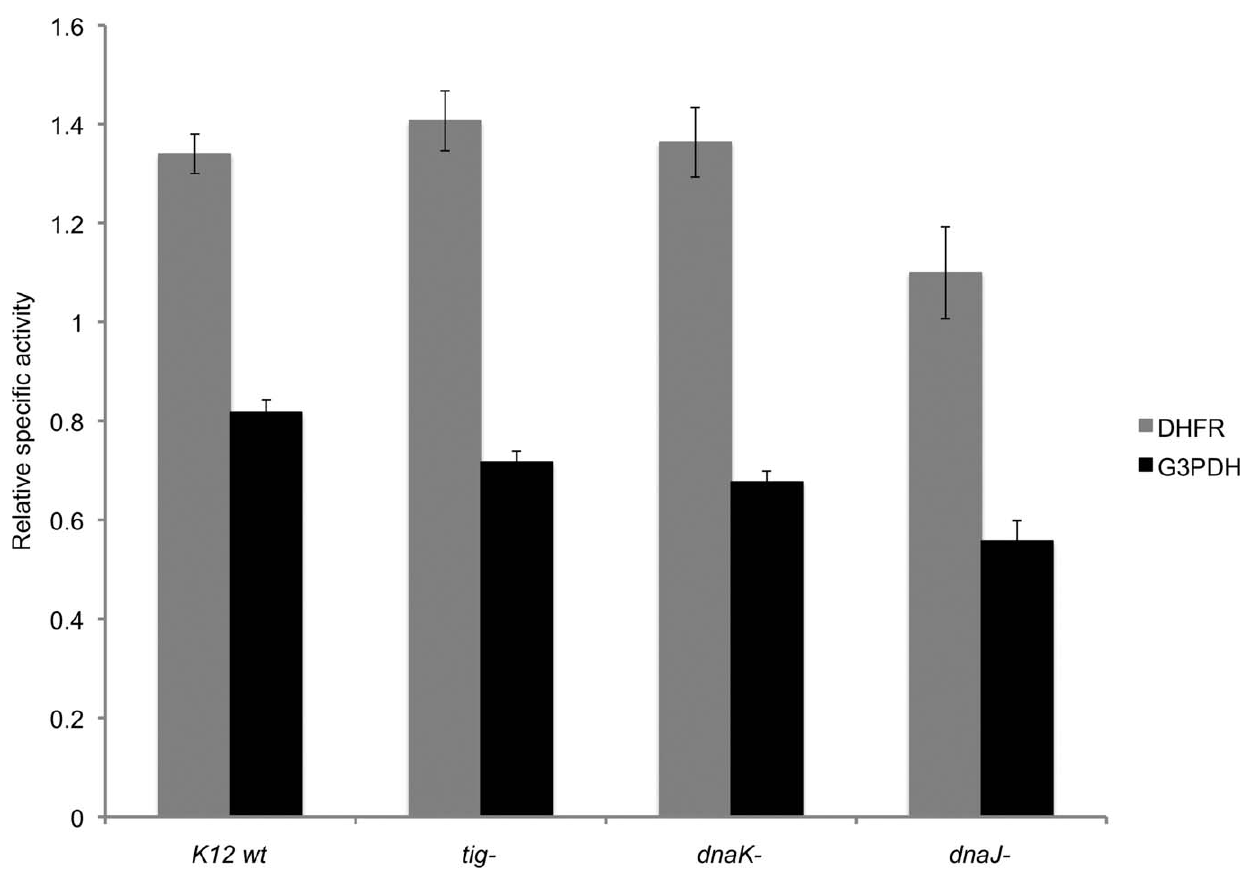
Figure 3. The effect of dnaJ , dnaK and tig gene deletions on the enzymatic activity of MBP-DHFR and MBP-G3PDH fusion proteins purified under native conditions. The data with error bars are expressed as mean 6 standard error of the mean (n=3). The relative values were obtained by normalization with a standard protein in each case. doi:10.1371/journal.pone.0049589.g003 PLOS ONE |